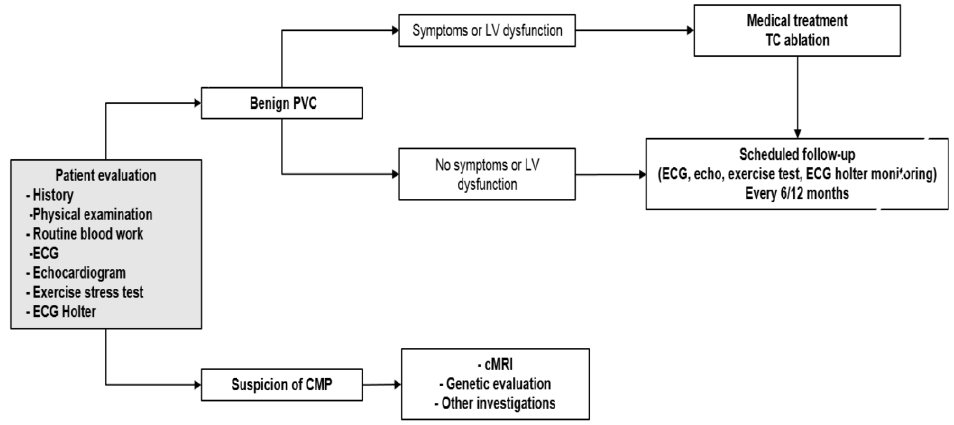
Figure 2. Diagnostic workflow of patients with premature ventricular contractions. Legend: CMP: Cardiomyopathy; cMRI: Cardiac magnetic resonance imaging; ECG: electrocardiogram; LV: left ventricular; PVC: Premature ventricular contractions; TC: transcatheter.